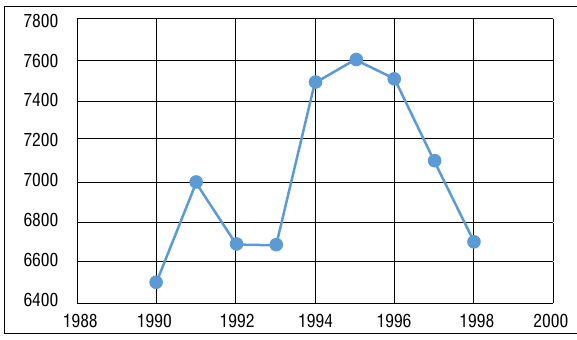
Scientific output of South African universities from 1990 to 1998. Conference proceedings, keynote addresses, works in progress,